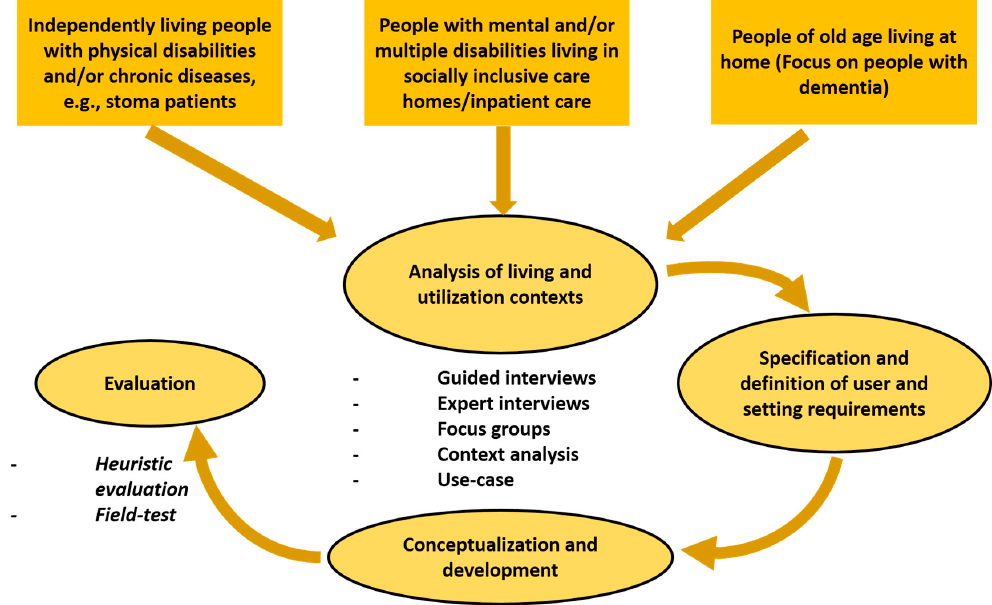
Figure 1. Visualization of the iterative user-centered research design that has been adopted within this research and development effort.